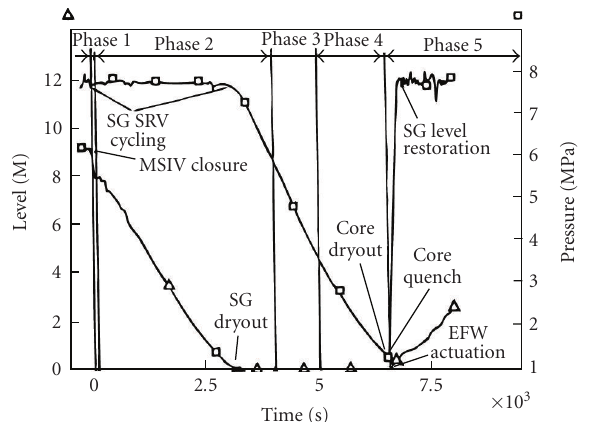
Figure 5: ISP-22 (SPES): experimental trends of steam generator pressure and level.